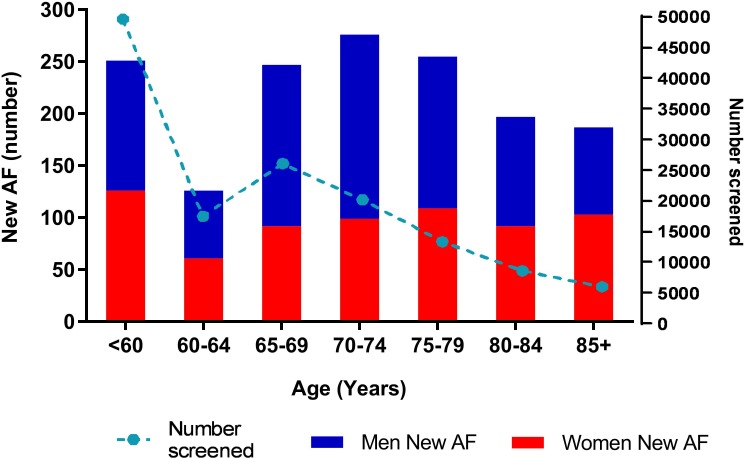
Total numbers of new AF by sex.AF, atrial fibrillation.